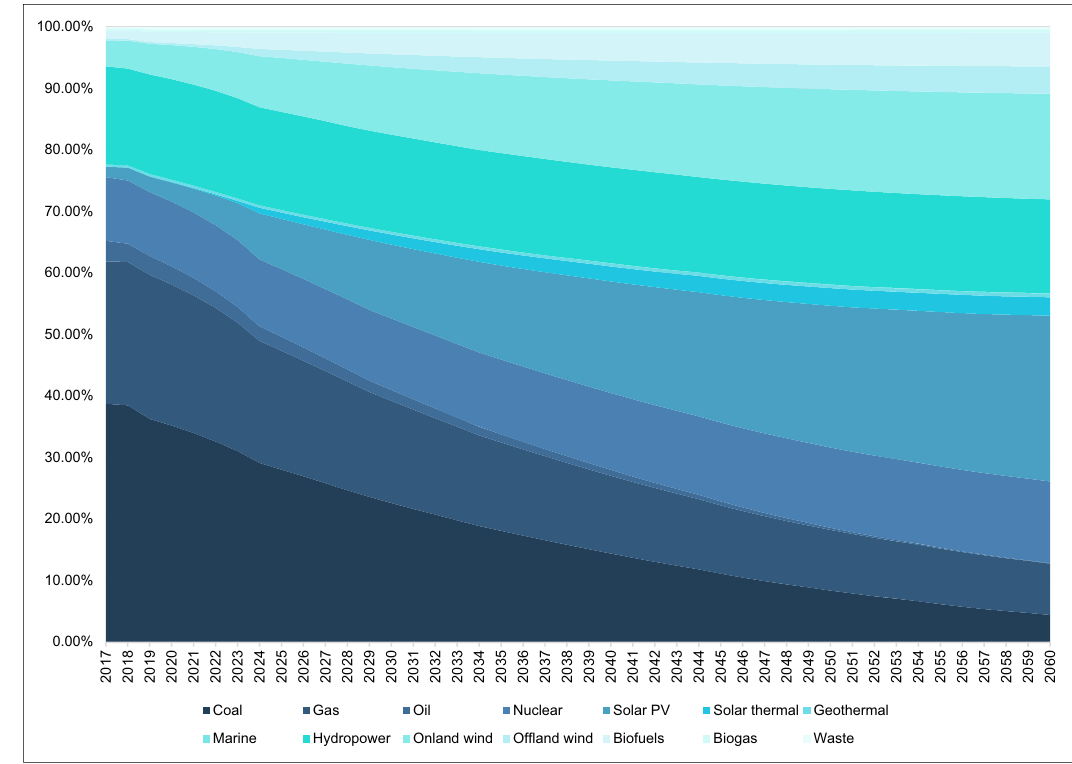
Fig. 4 Projection to global electricity power production composition from 2017 to 2060. The ribbons in different colour intensity scales represent the share of various power generation technologies. The world total is obtained from the International Renewable Energy Agency (IRENA) 61 . The power- generation composition is projected by the integrated modelling system (IMS) model simulations based on country-/economy-speci fi c National Determined Contributions (NDCs) or long-term energy mix target commitments of 24 major solar photovoltaic (PV) applications and trade partner countries/economies. That of the countries/economies other than these 24 countries/economies is obtained by subtracting the subtotal of the 24 countries/economies from the world total (See the Methods section, Data sheet 13 in Source data and Supplementary Information 5 for more